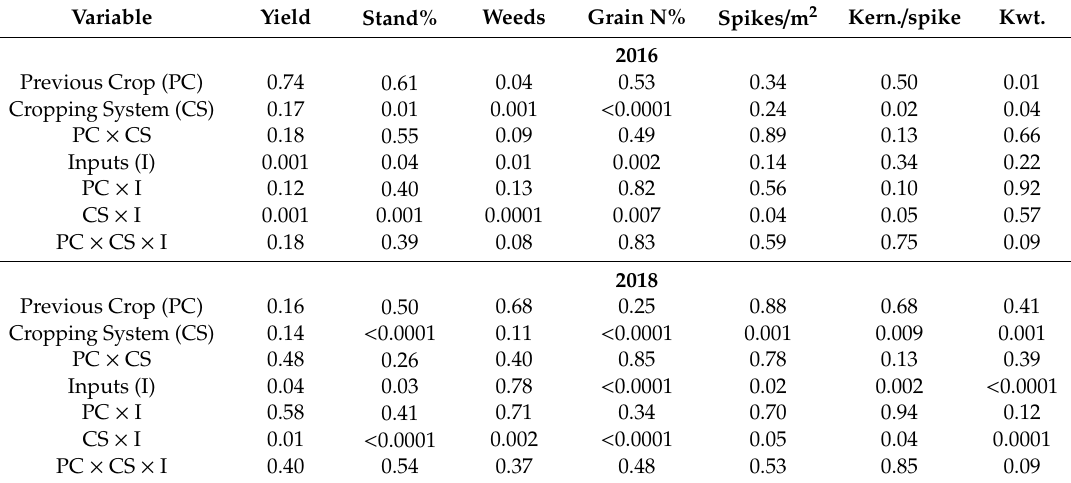
Table 3. p -Values for yield, early stand%, weed density, grain N% concentration, plants / m 2 , spikes / plant, kernels (kern.) / spike, and kernel weight (Kwt.) in 2016 and 2018 on a research farm in central New York, USA.